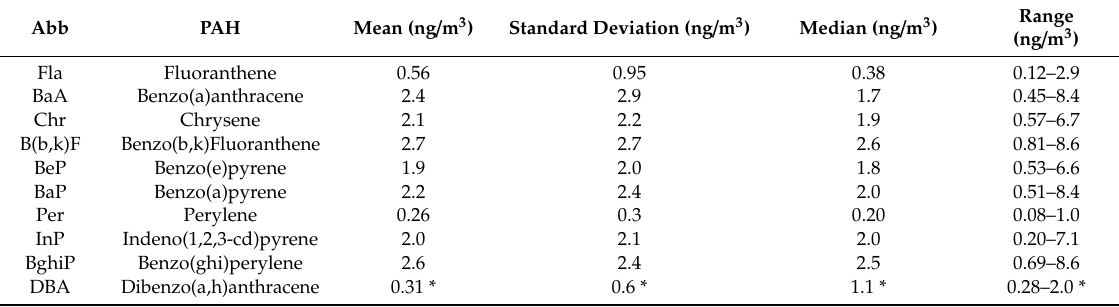
Table 3. PM 2.5 associated polycyclic aromatic hydrocarbons (PAHs) (ng / m 3 ) at the urban sampling station Graz DB, 2 January–31 March 2017. Overview of 14 sample pools, except for DBA* where only 7 sample pools showed quantifiable